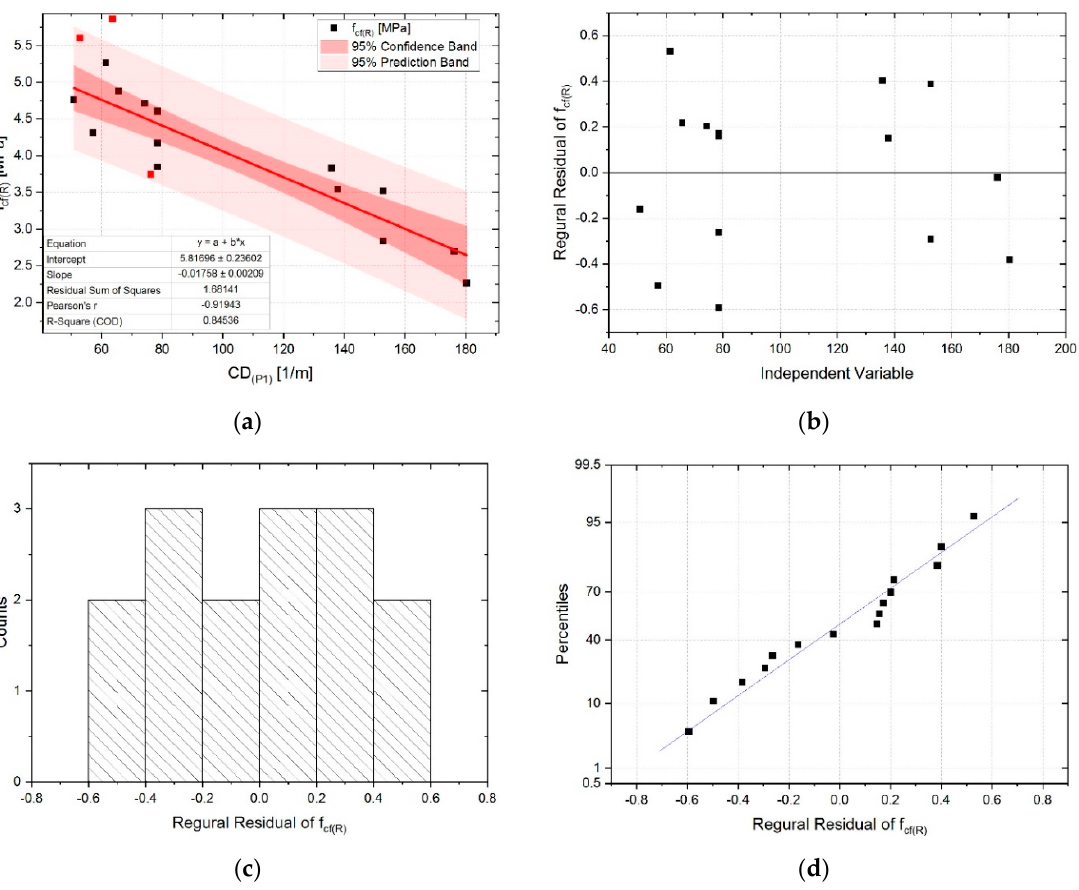
Figure 10. Results of the linear regression analysis for the CD (P1) -f cf(R) relationship together with residual plots: ( a ) regression line (red points—outliers); ( b ) residuals vs. independent; ( c ) histogram of residuals; ( d ) normal probability of residuals.